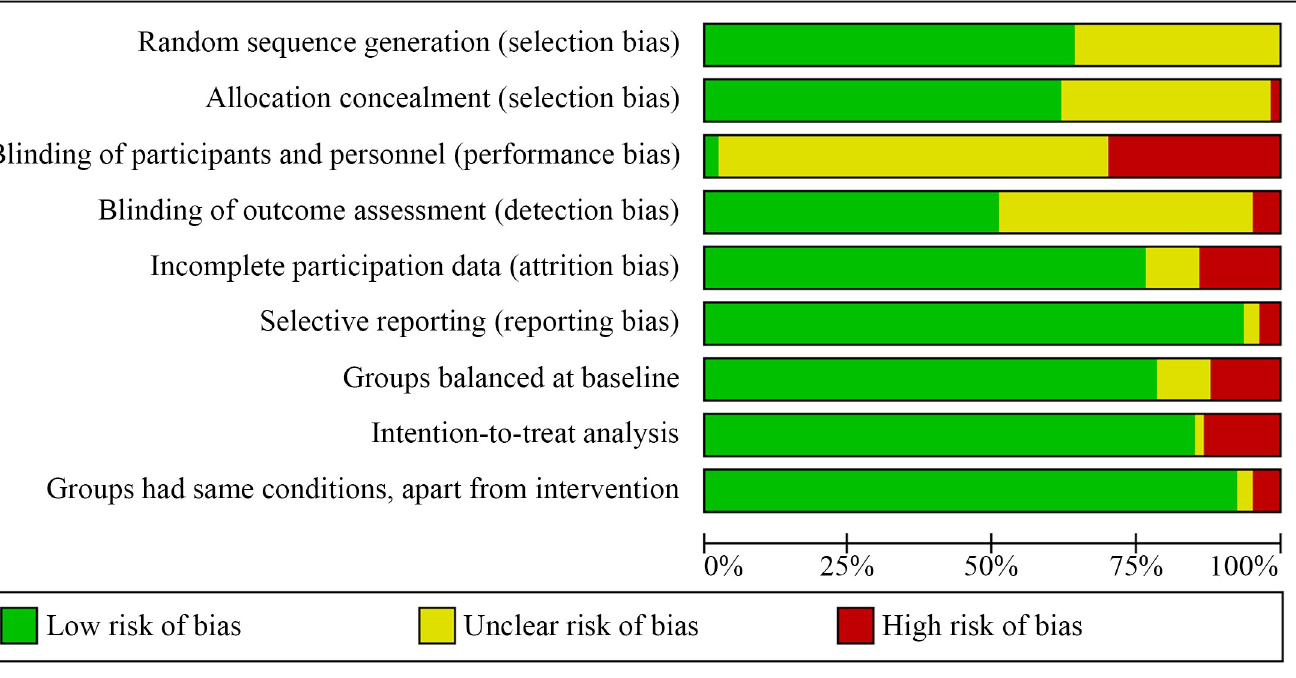
Fig 2. Risk of bias graph of characteristics across 106